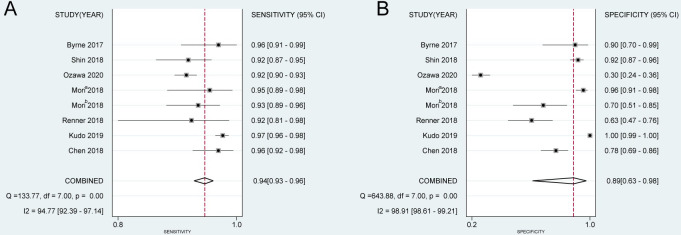
The pooled diagnostic accuracy index of CNN system in the field of CP classification.(A) Sensitivity, (B) specificity. a: rectosigmoid; b: proximal-rectosigmoid. CNN: convolutional neural networks; CP: colorectal polyps.